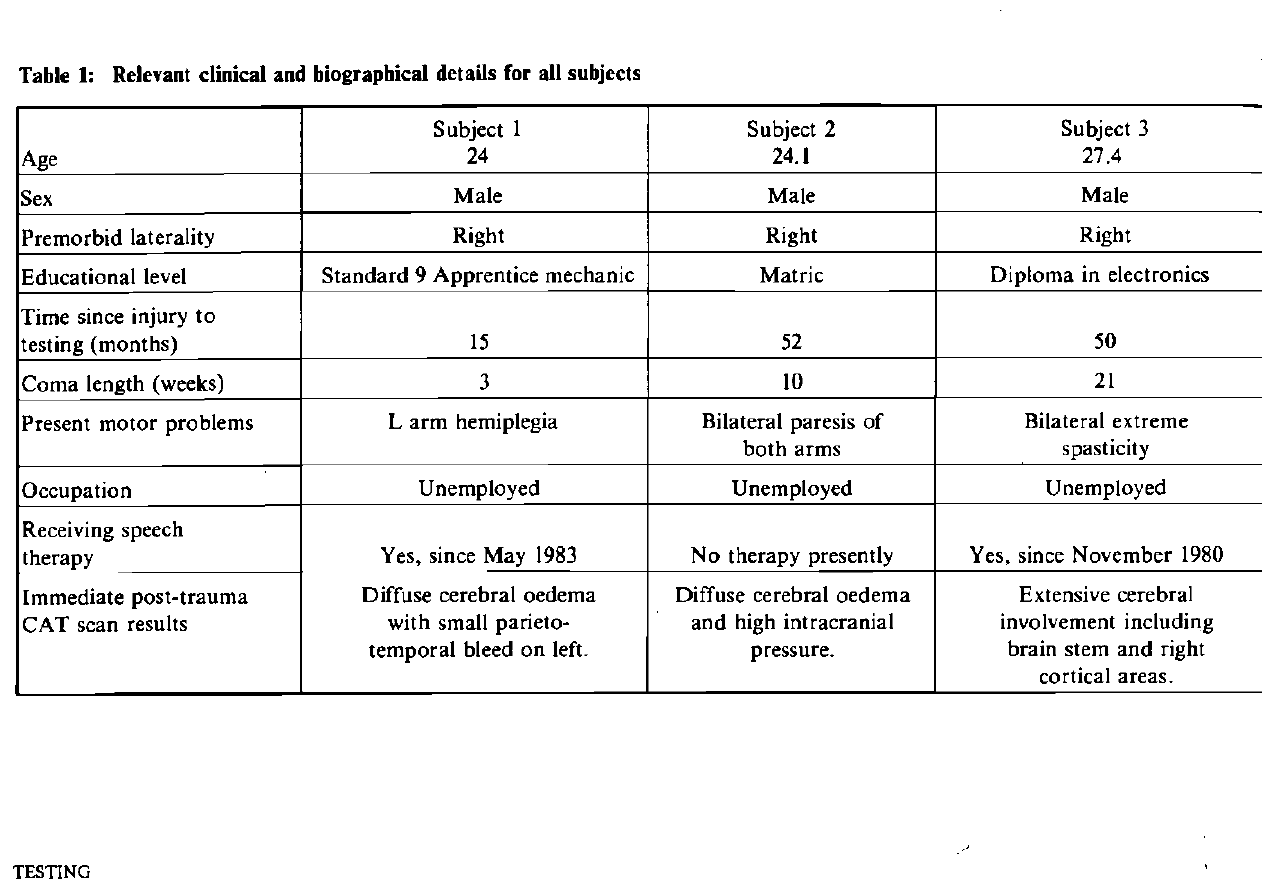
Table 1: Relevant clinical and biographical details for all subjects